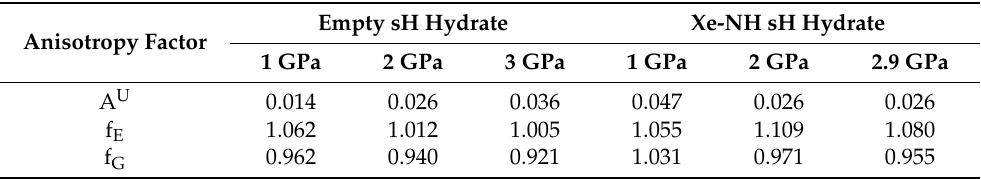
Figure 5. Pressure-dependent anisotropy of CO 2 -NH sH gas hydrate presented by the universal elastic anisotropy index (A U ) and Young’s (f E ) and shear (f G ) moduli anisotropy factors at 0 K. Table 7. Universal elastic anisotropy index (A U ) and Young’s (f E ) and shear (f G ) moduli anisotropy factors of empty and Xe-NH sH gas hydrates under pressure and at 0 K.